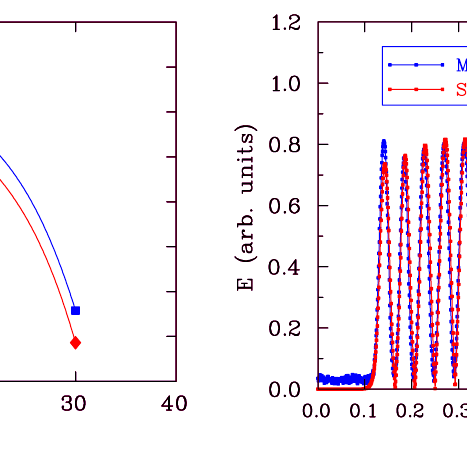
FIG. 21. (Color) Comparison between the measured and simu- lated frequency shift using the tuners shown in Fig. 20. With an identical tuner height of 30 mm for all 10 tuners a frequency shift of almost (cid:3) 1% of the resonance frequency could be achieved.